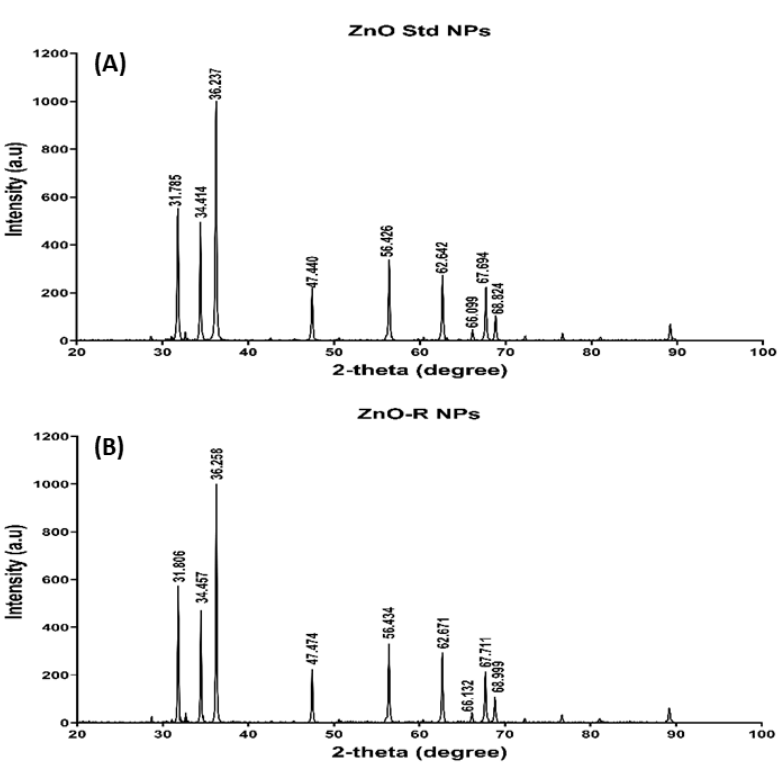
Figure 4. XRD of ( A ) ZnO Std NPs and ( B ) ZnO-R NPs.